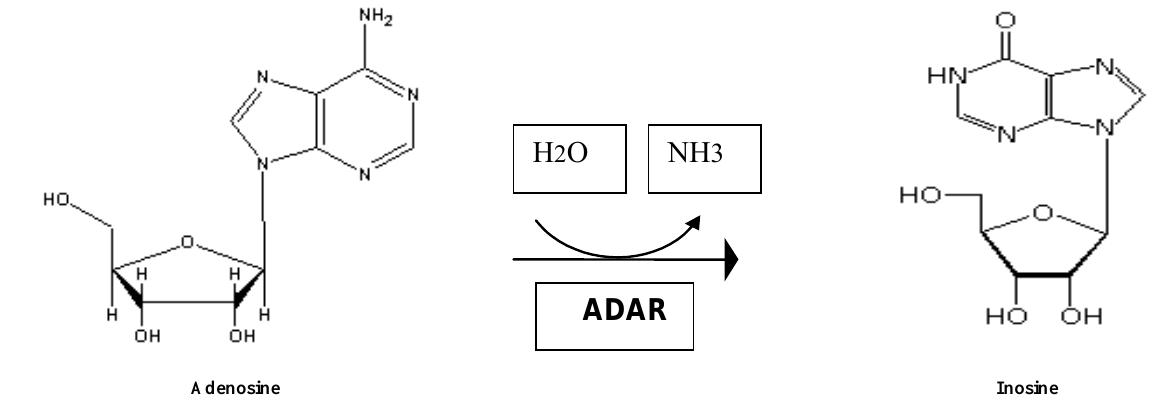
FIGURE 3 . Catalytic activity of ADAR enzymes: ADARs catalyze the C6 deamination of adenosines on double-stranded RNA substrates to form inosines. The oxygen in water acts as a nucleophile, attacking the C6 of adenosine.